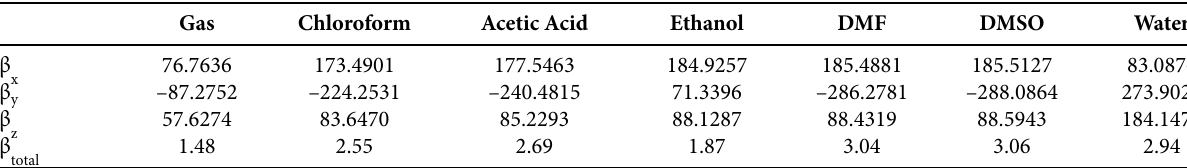
Table 3. β × 10 −30 (esu), βx, βy, βz, in (a.u.) components and values calculated using DFT levels of theory for Iopamidol.